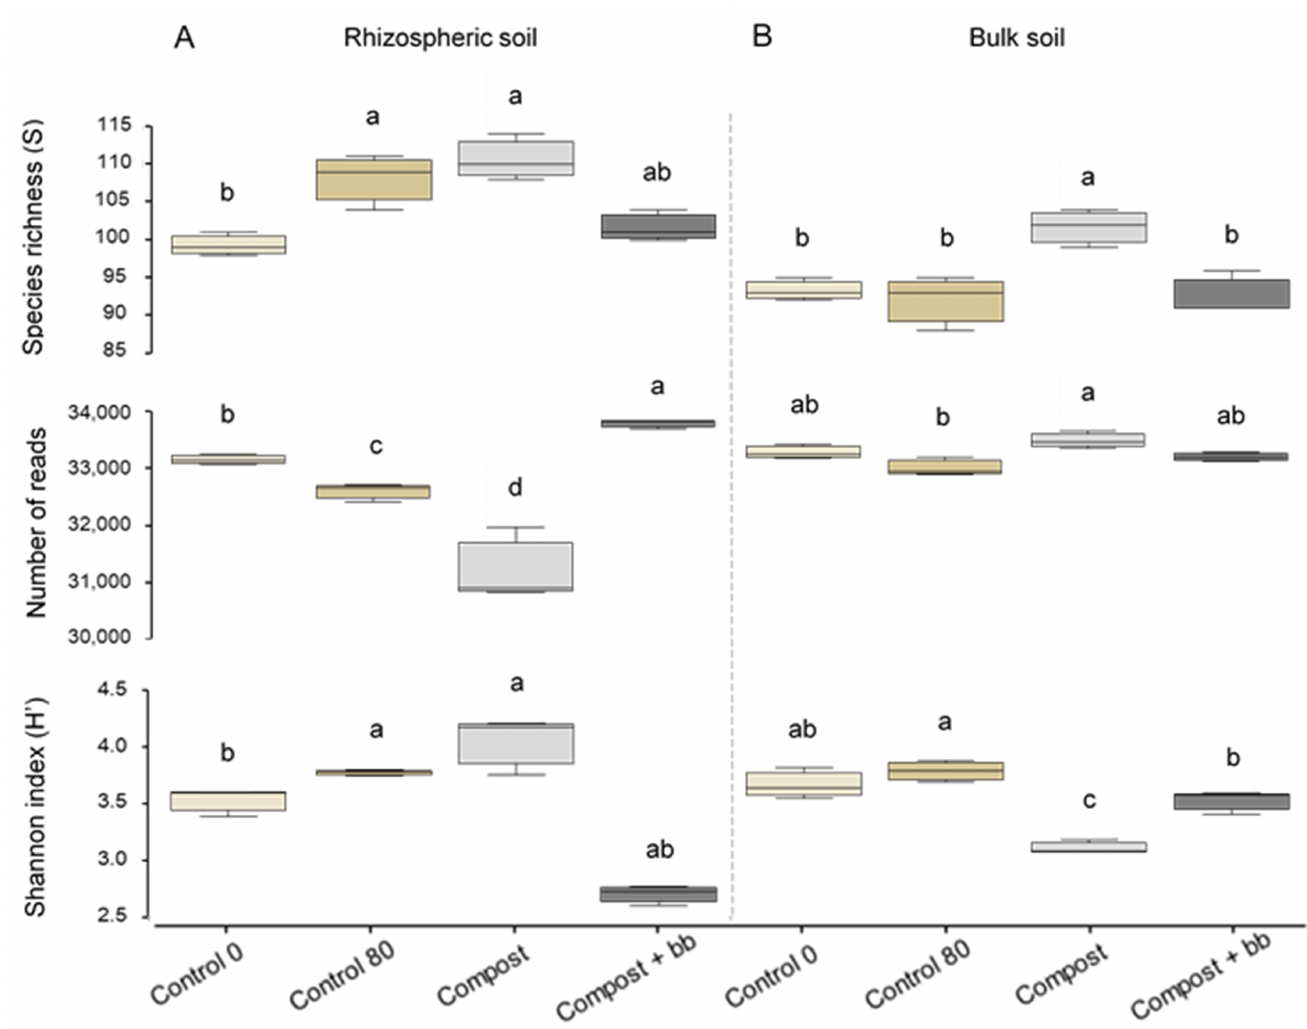
Figure 6. Boxplots showing the distribution of diversity indices for the fungal community in each treatment in ( A ) rhizospheric and ( B ) bulk soil. S, number of ASVs/number of amplicon sequence variants; number of reads for the bacterial community; H’, Shannon index. The lower and upper bounds of the boxplots show the first and third quartiles (the 25th and 75th percentiles), the middle line shows the median, and the whiskers above and below the boxplot indicate inter-quartile ranges. Different letters indicate significant differences for p -values below 0.05 according to Tukey’s HSD